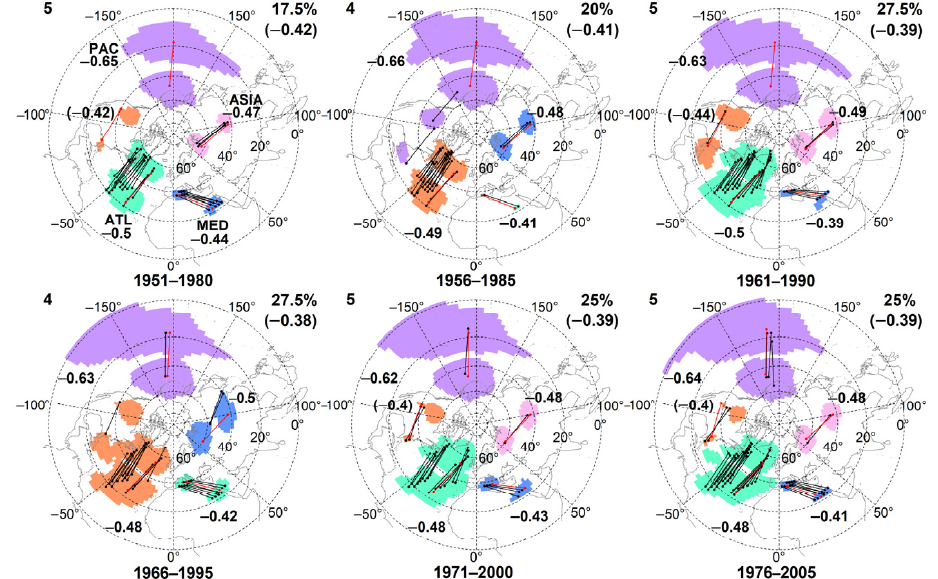
Figure 2. Reference CP maps obtained from the ERA-20C for the six time periods used in the study. The four reference clusters are texted in the CP map on the top-left corner of the figure. The correla- tions associated with the ACs (denoted with red dots connected with red lines) are provided on the maps, next to the clusters. Interpretation of the maps is similar to that of Figure